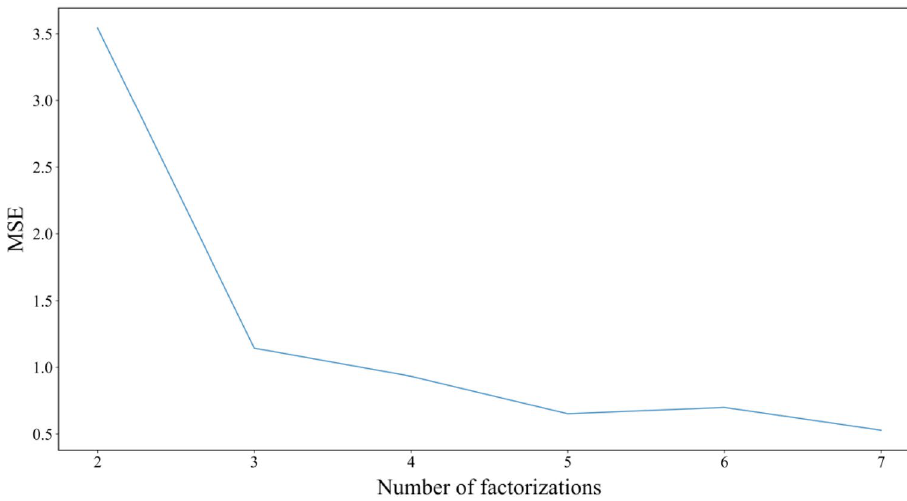
Figure 7. Index evaluation of different decomposition numbers in the BiLSTM training set.